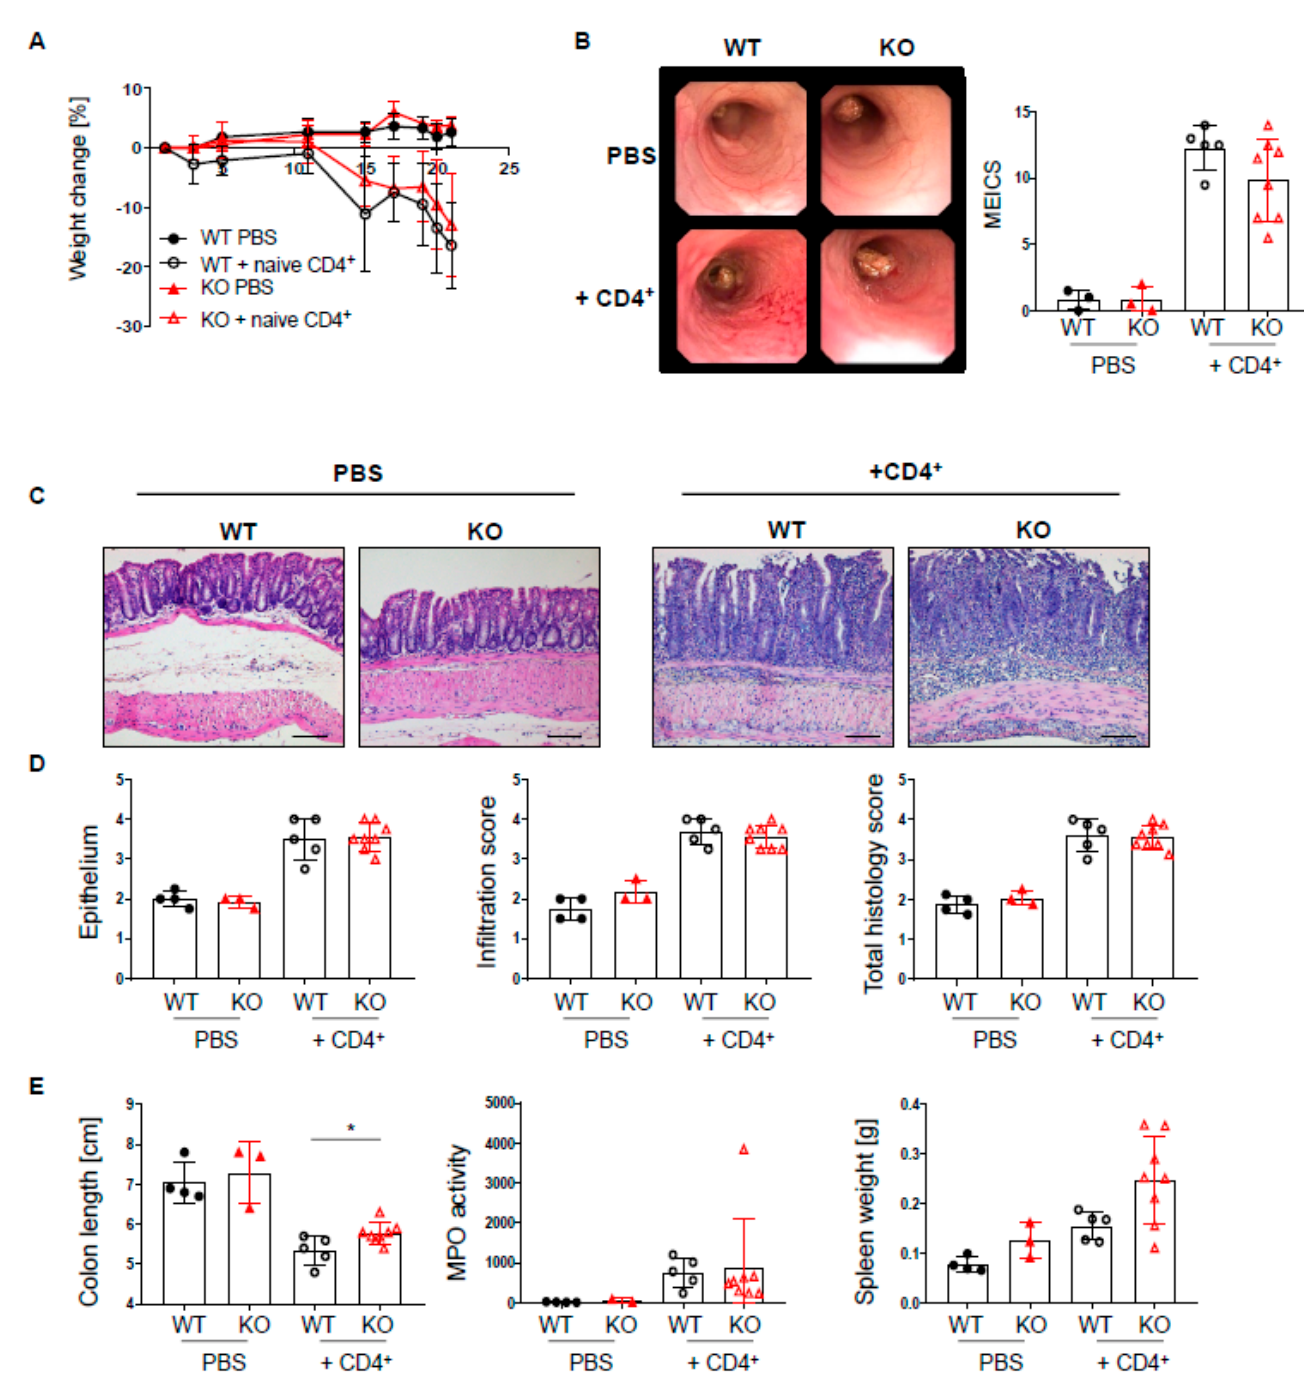
Figure 6. Loss of PTPN2 in DCs does not aggravate colitis severity in a T cell transfer colitis model. PTPN2 fl/fl xRAG − / − (WT) and PTPN2 fl/fl xCD11c Cre xRAG − / − (KO) mice were injected i.p. with PBS or 2.5 × 10 5 naive CD4 + T cells: ( A ) weight development post injection; ( B ) representative pictures from colonoscopy and assessment of colitis severity according to the murine endoscopic index of colitis severity (MEICS); ( C , D ) representative pictures from H&E staining of the terminal colon and histological scoring; ( E ) colon length, spleen weight, and MPO activity. Scale bars represent a length of 100 mm. * p < 0.05; unpaired Mann–Whitney test. Data are representative for one out of two independent experiments with 3–5 mice per experimental group.